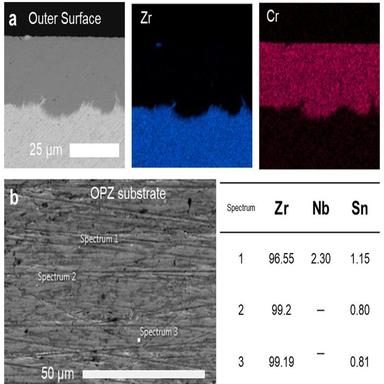
a) SEM of as-received Cr-coated OPZ with EDS maps of zirconium and chromium; b) point weight percentage composition measures within the OPZ substrate.